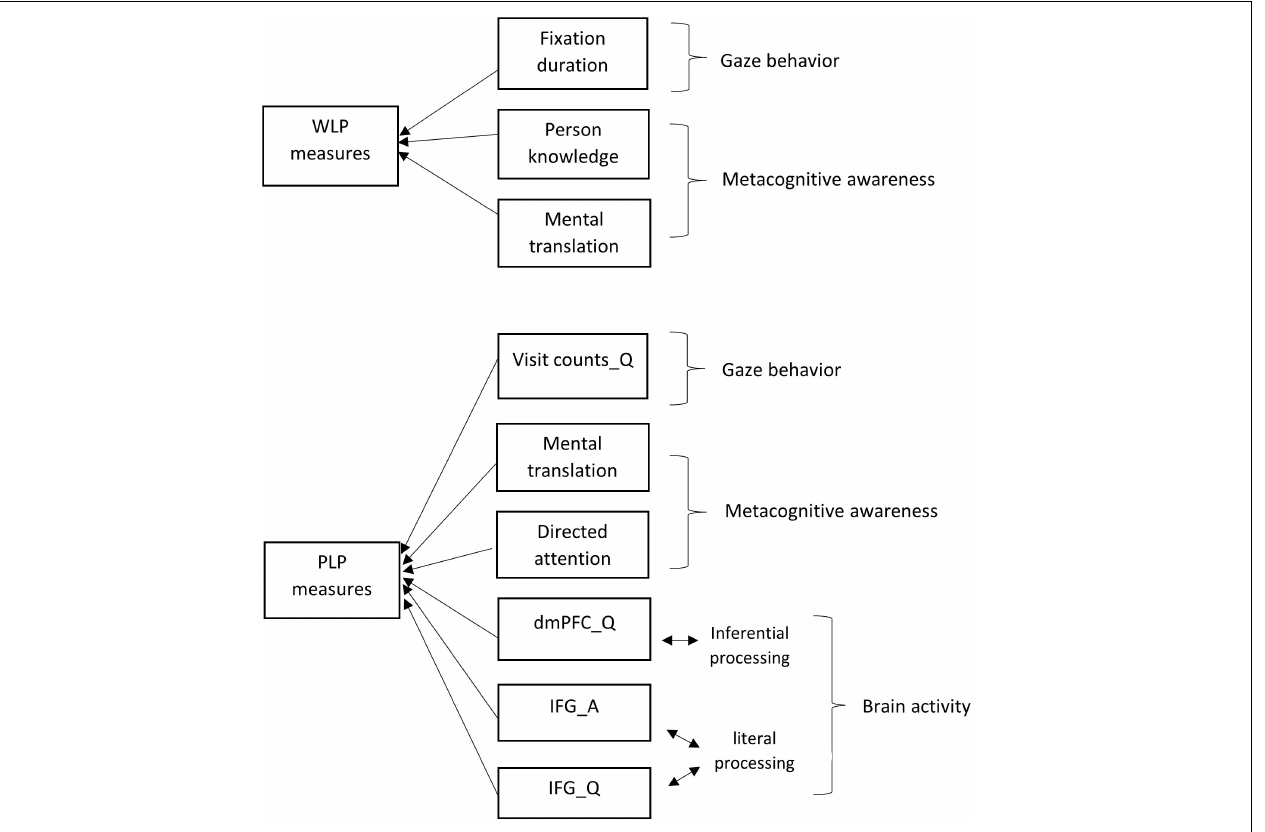
FIGURE 3 | The visual representation of the ALM models for the WLP and PLP test methods. A, the audio texts listening phase; ALM, automatic linear modeling; dmPFC, dorsomedial prefrontal cortex; IFG, inferior frontal gyrus; PLP, post-listening performance; Q, the answering phase; WLP, while-listening